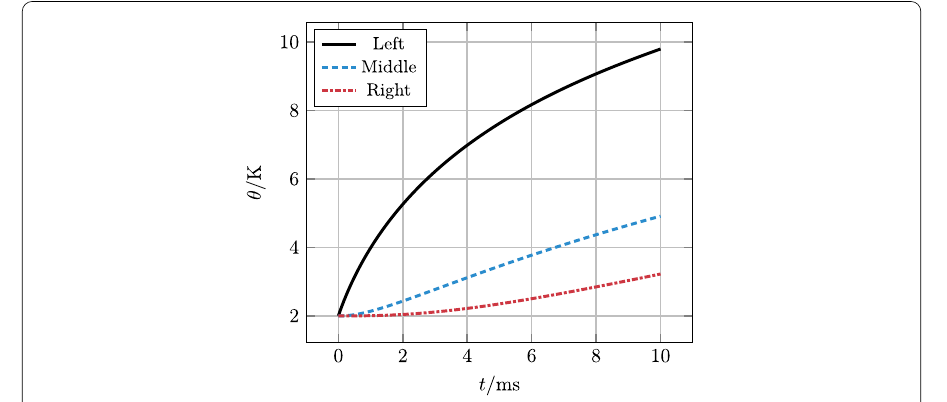
Figure 6 Evolution of the temperature in the three cables over time. Evaluated at z = z q and in the center of the cross-section of each cable